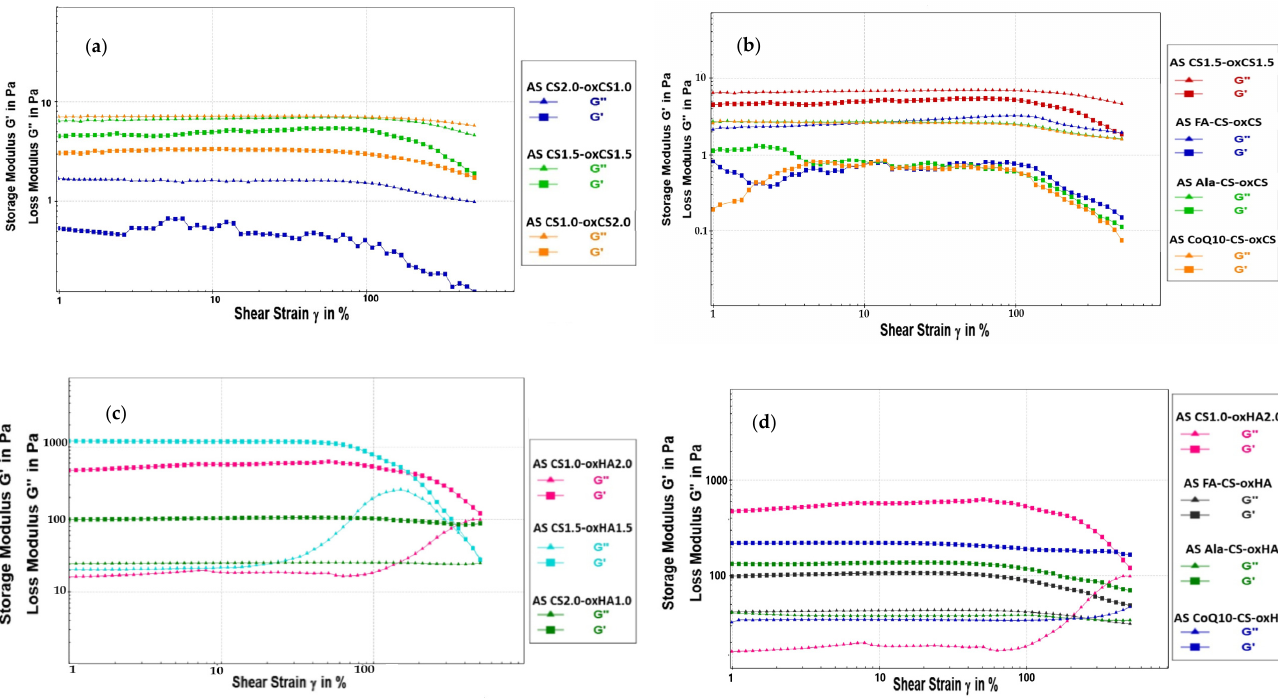
Figure 9. The amplitude sweep diagram for CS-oxCS ( a ), API-CS-oxCS ( b ), CS-oxHA ( c ), and API-CS-oxHA ( d ) hydrogels.